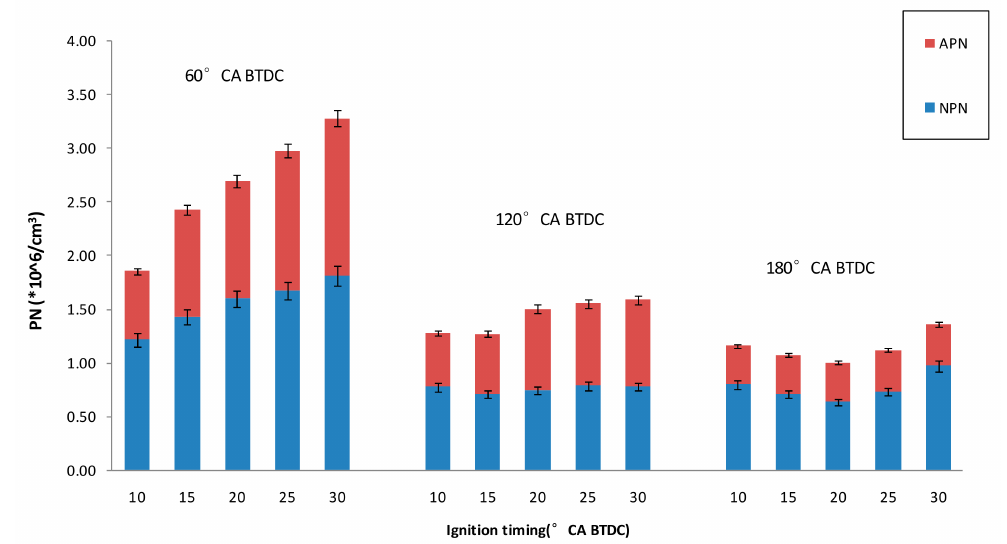
Figure 14. Particle number with ignition timing for di ff erent direct injection timing (At G25 and 2100 r / min and the intake manifold absolute pressure is 42